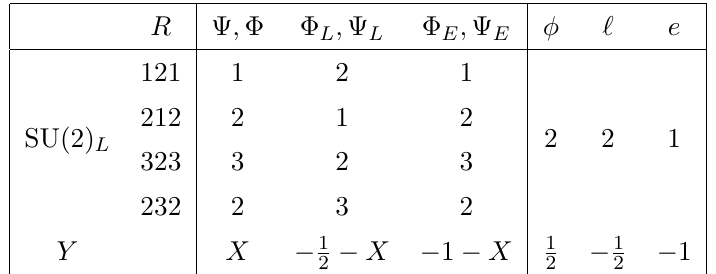
Table 1 . Charge assignments and representations under SU(2) L × U(1) Y for the SM fields and the different new